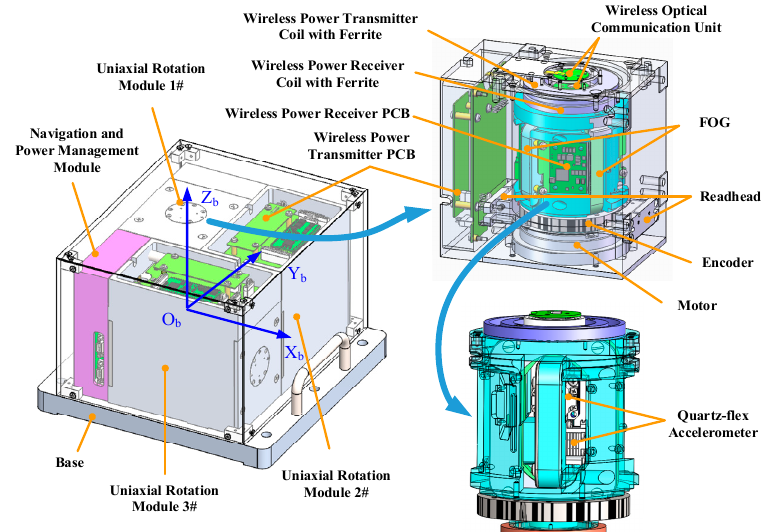
Figure 1. The mechanical structure of URMINS.